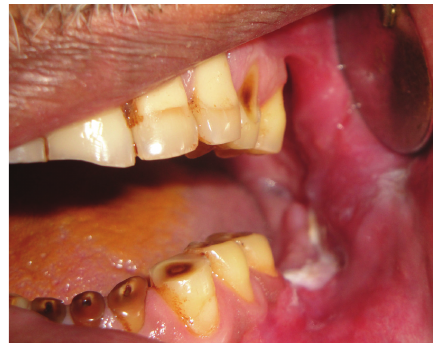
Figure 2: Intraoral examination revealed missing molars.